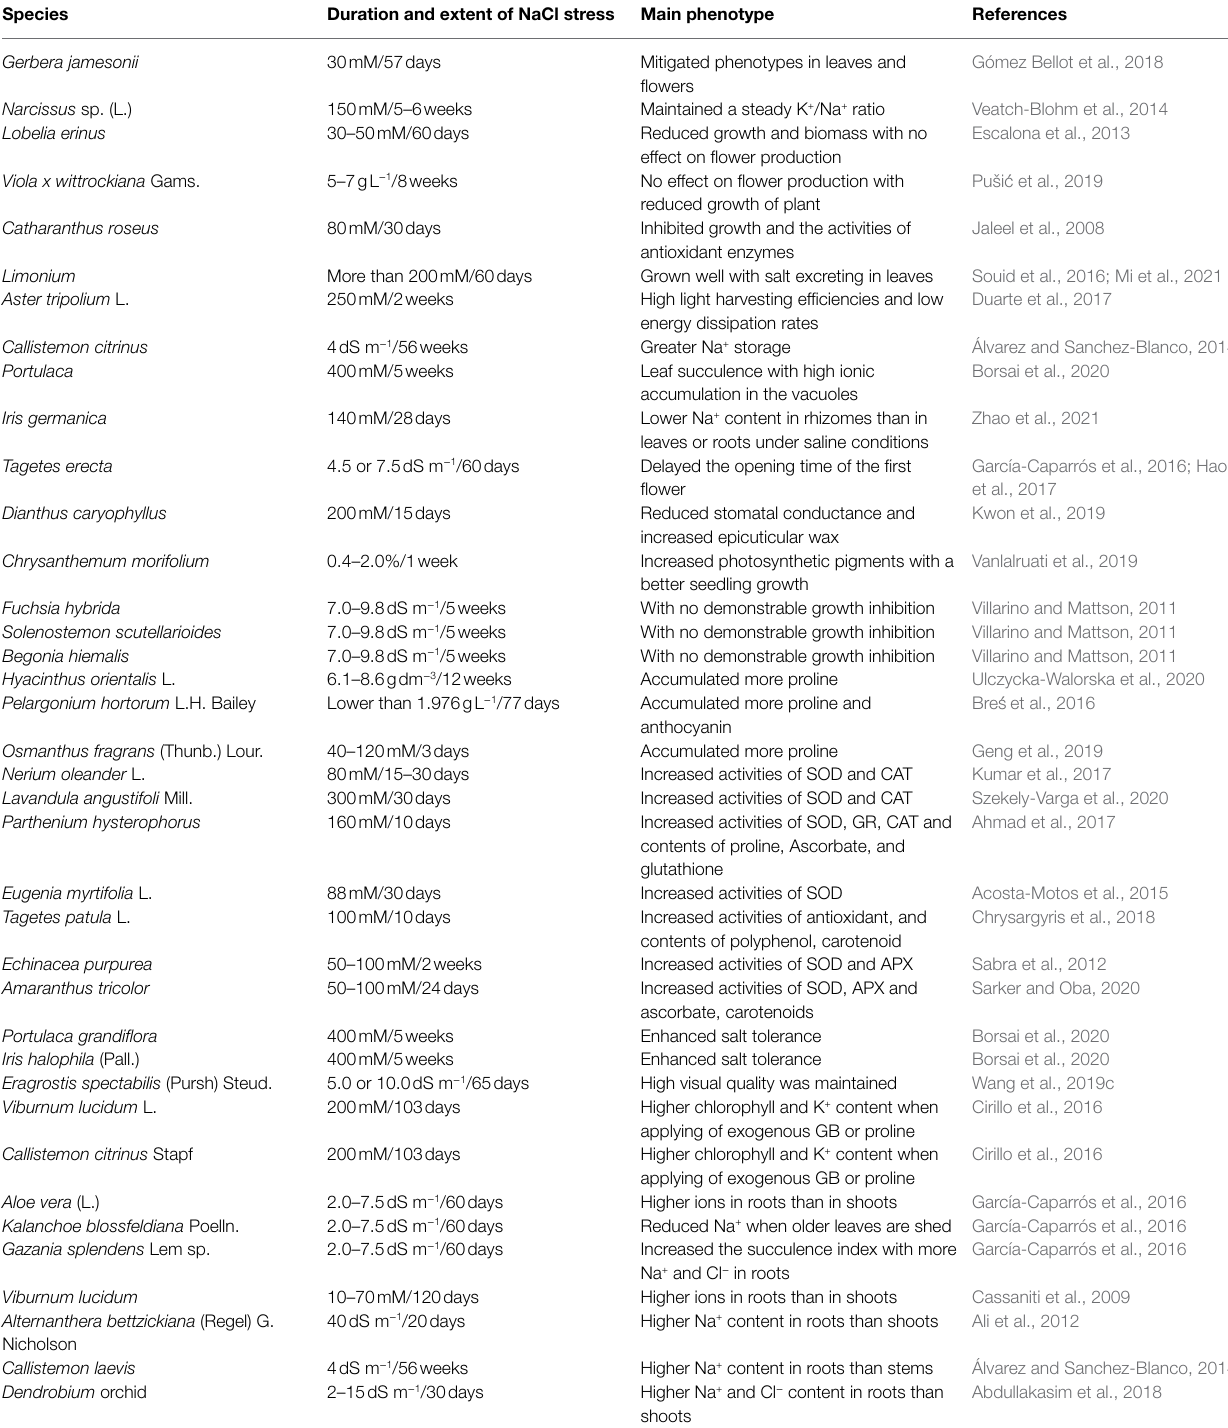
TABLE 1 | The detailed experimental conditions of the ornamental flowering plants exposed to salt